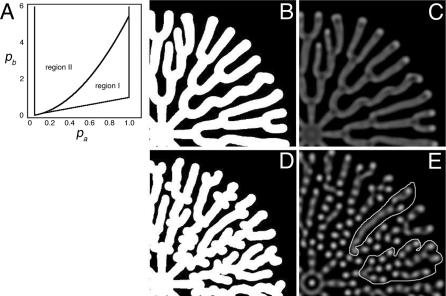
Patterns Generated by the Linear Dynamics(A) Region I indicates a parameter region on a (pa − pb)-plane that satisfies the classical Turing condition. pc does not appear in the Turing condition. Region II is as described in the legend of Figure 5.(B,C) and (D,E) Examples of patterns generated in region II and region I, respectively. Magnified images of dendrites (B,D) and those of activator distributions (C,E). Parameter values were pa = 0.5, pb = 2.5, and pc = 0.16 (B,C) and pa = 0.6, pb = 2.9, and pc = 0.2 (D,E). Other parameters were the same as in Figure 3A, except for A
max = 10.0 and Tr = 0.75. Conditions of simulation were as described in the legend of Figure 3.